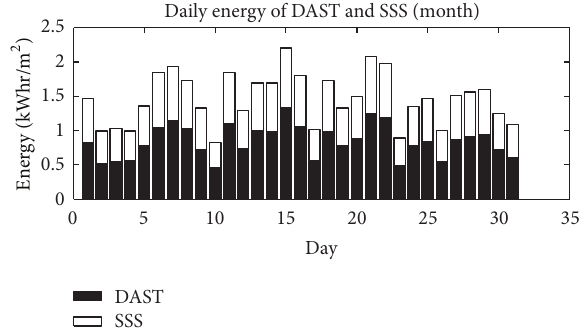
Figure 11: The daily energy captured by DAST and SSS for a month.